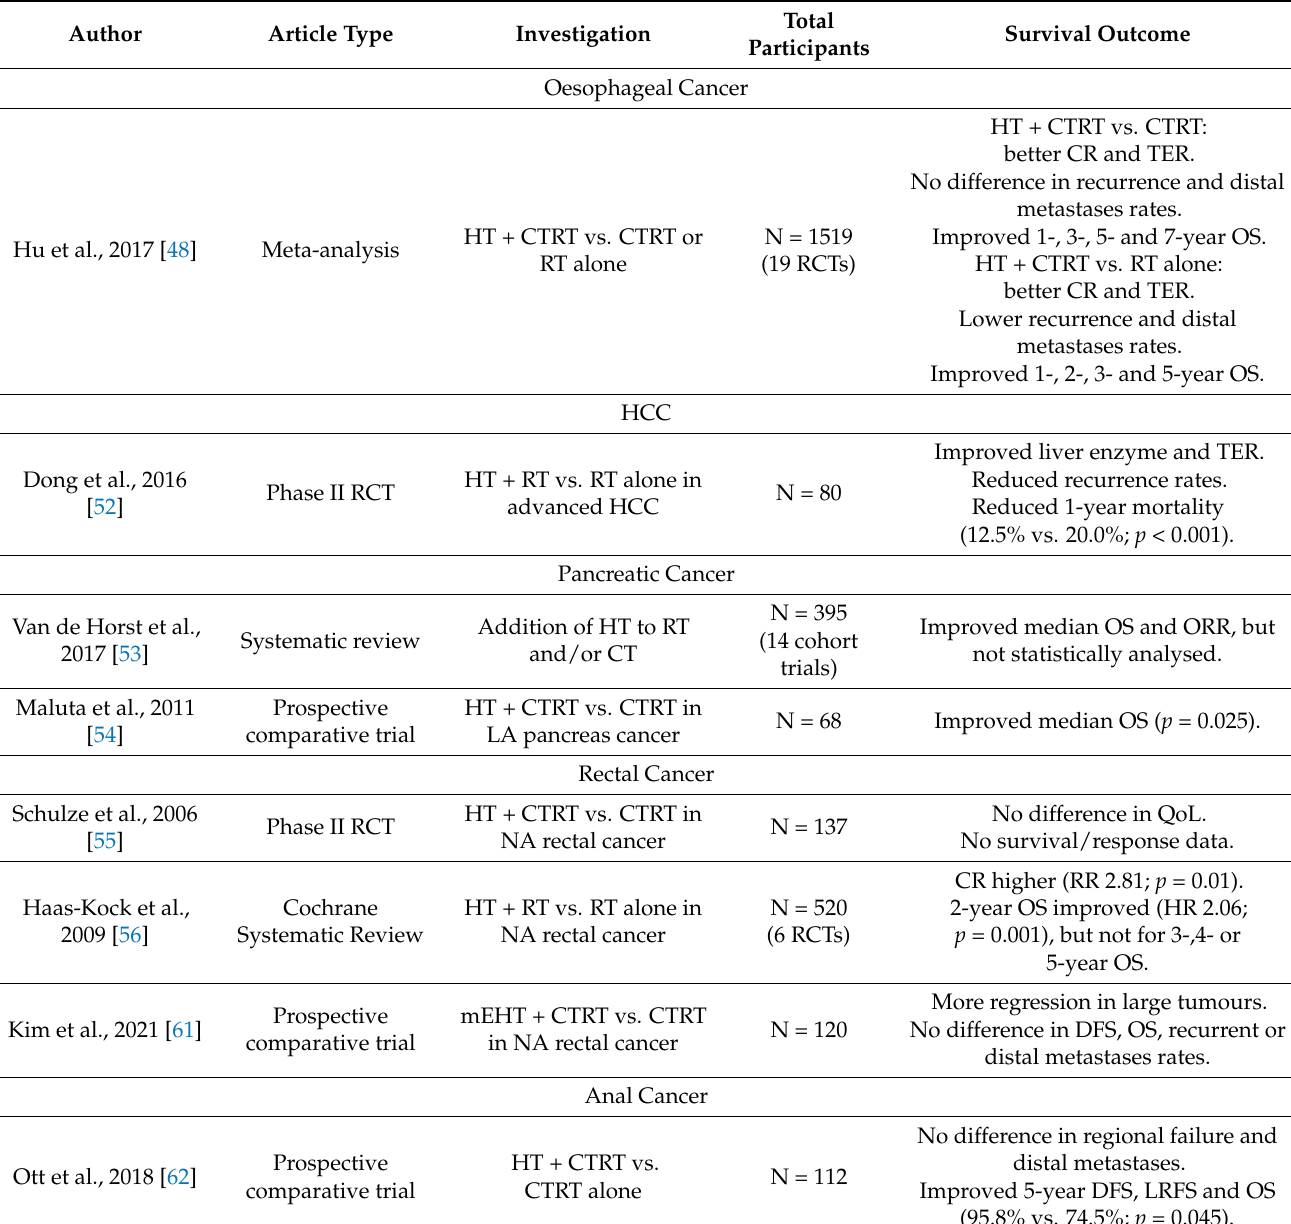
Table 3. HT in patients with gastrointestinal and hepato-pancreatic cancers. Summary of articles